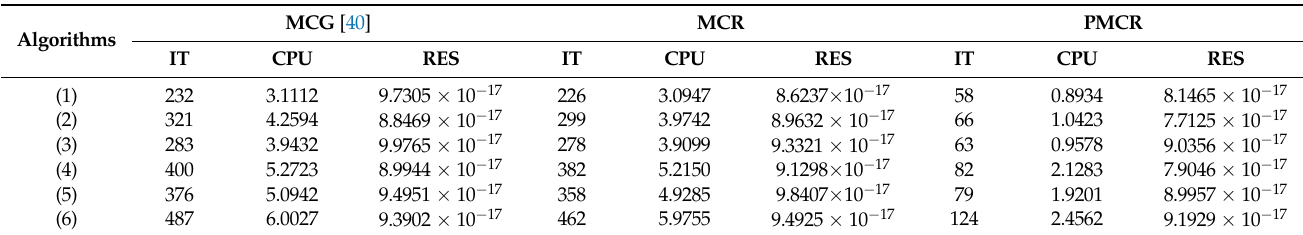
Table 2. Comparison results of Example